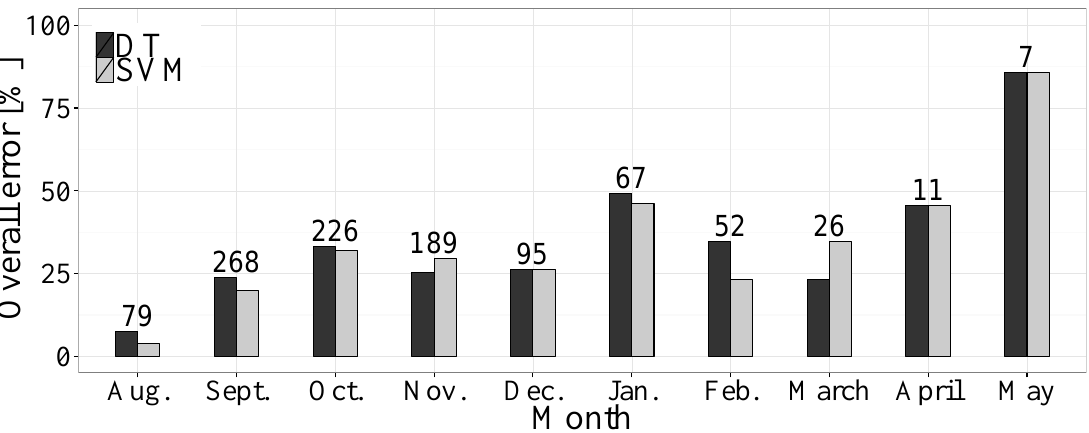
Figure 7. Overall error per month for the DT and the SVM (numbers written above each bar correspond to the number of data points per